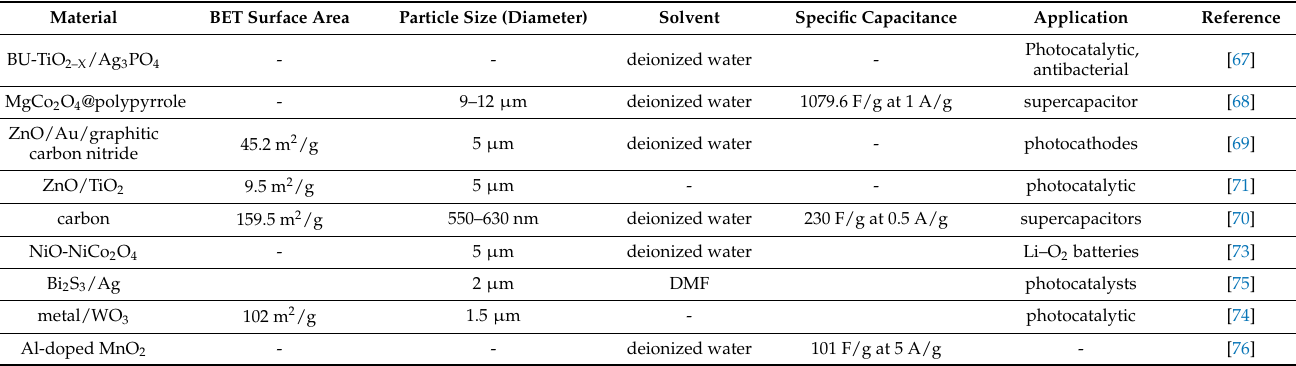
Table 3. The properties and application of urchin-like composite